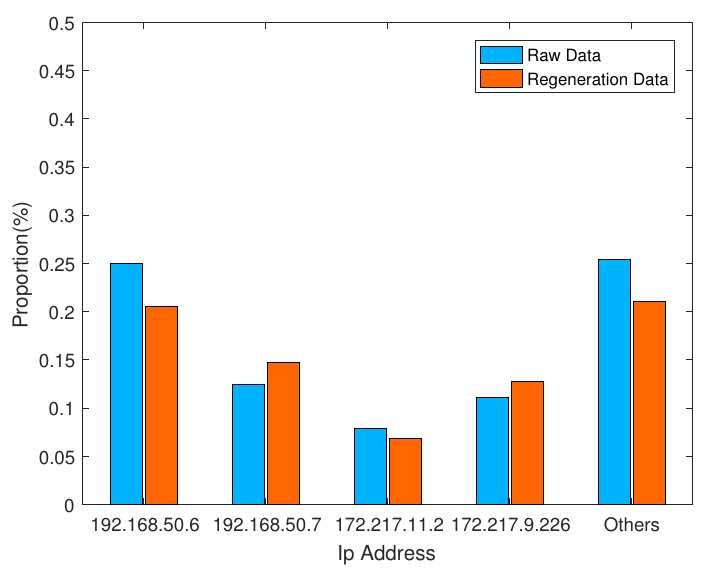
Figure 8. Probability Comparison Chart of Attack Packets and Sample